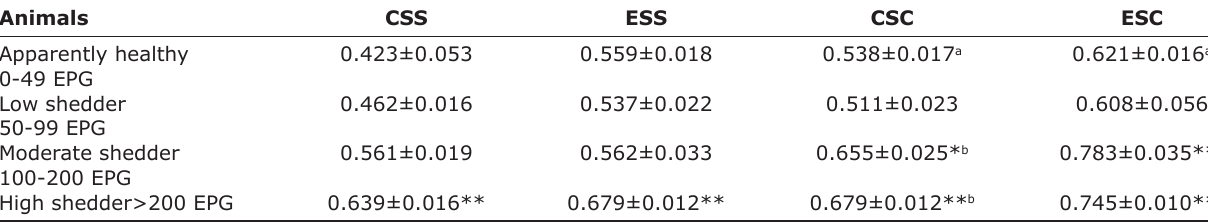
Table-2: OD values of IgG for CSS, ESS, CSC and ESC in donkey (450 nm). Animals